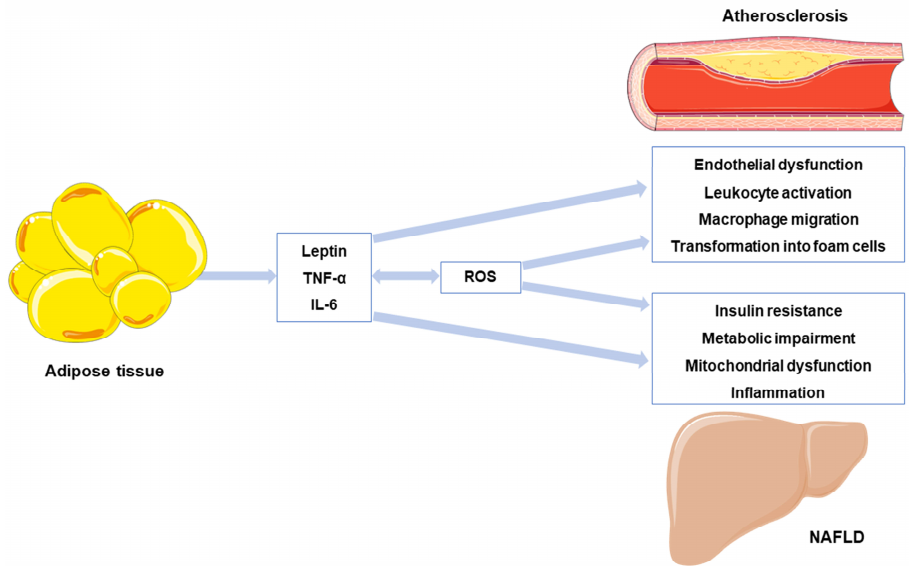
Figure 1. In the context of obesity and lipid overload, adipocytes acquire a proinflammatory phe- notype that induces the secretion of adipokines, such as leptin, TNF-α, or IL-6. These adipokines promote ROS production and oxidative stress, which in turn stimulate proinflammatory adipokine secretion. Both types of cellular stress, inflammation and oxidative stress, play a role in the progres- sion of atherosclerosis and non-alcoholic fatty liver disease (NAFLD), promoting several pathogenic processes. ROS: reactive oxygen species; TNF: tumor necrosis factor α; IL-6: interleukin 6. This fig- ure has been edited from Servier Medical Art. Servier is licensed under a Creative Commons Attrib- ution 3.0 Unported License.